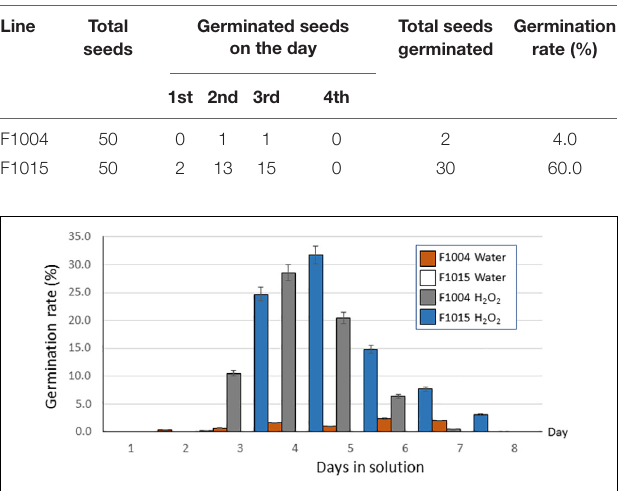
FIGURE 1 | Percent of seeds germinated as a function of time in solution for seedballs of sugarbeet lines F1004 and F1015 that were germinated in a 1% H 2 O 2 solution or distilled water for 8 days. No seeds of F1015 were germinated under water control.